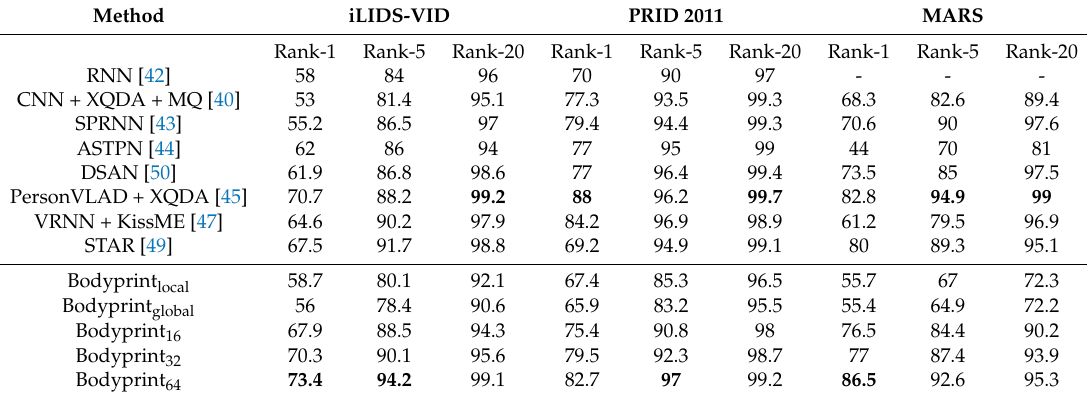
Table 1. Quantitative comparison between the proposed method and the current state-of-the-art methods on the chosen datasets. The best results are highlighted in